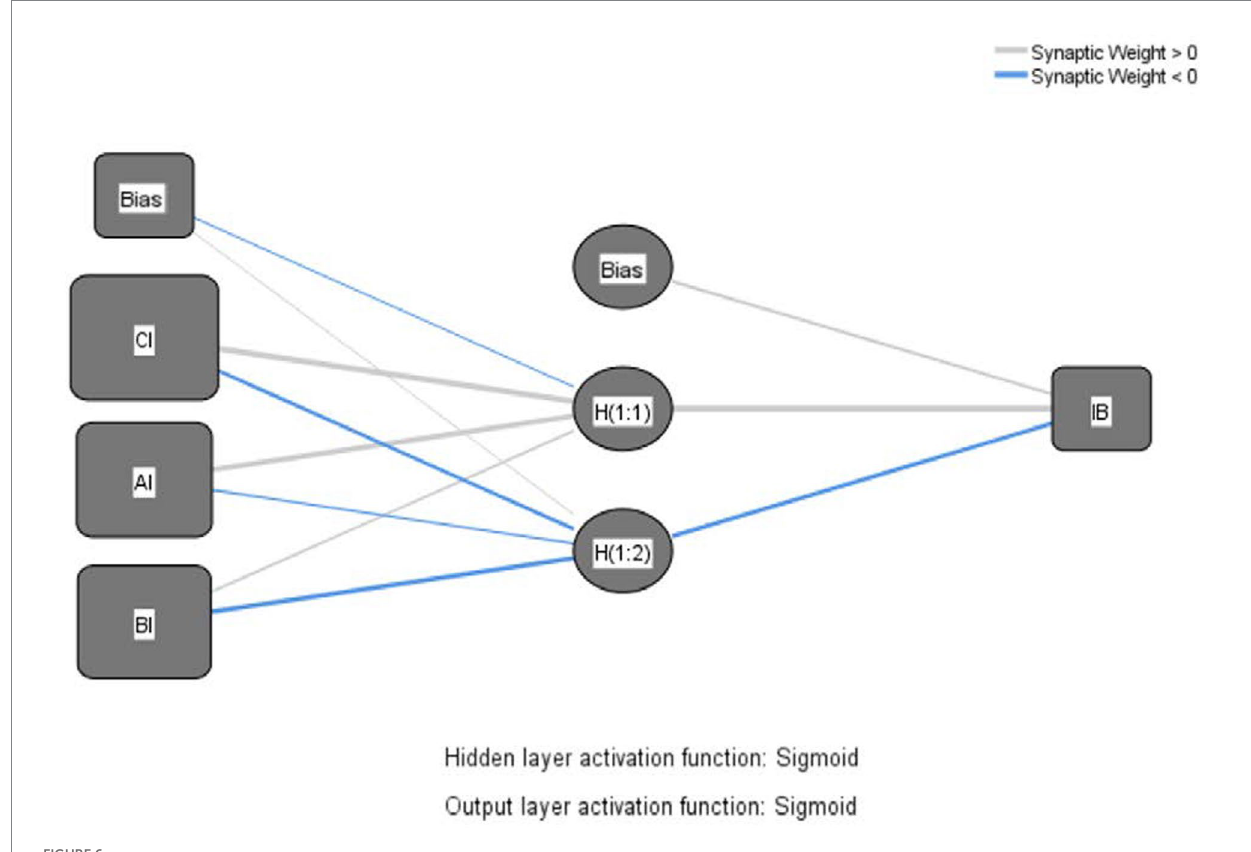
FIGURE 6 Neural network model – impulse buying